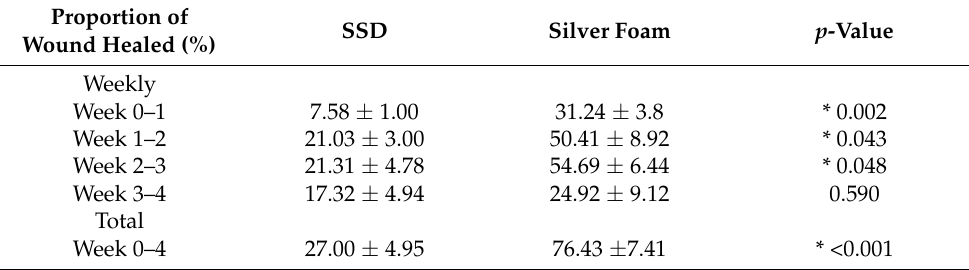
Table 2. Analysis of wound healing between both groups.